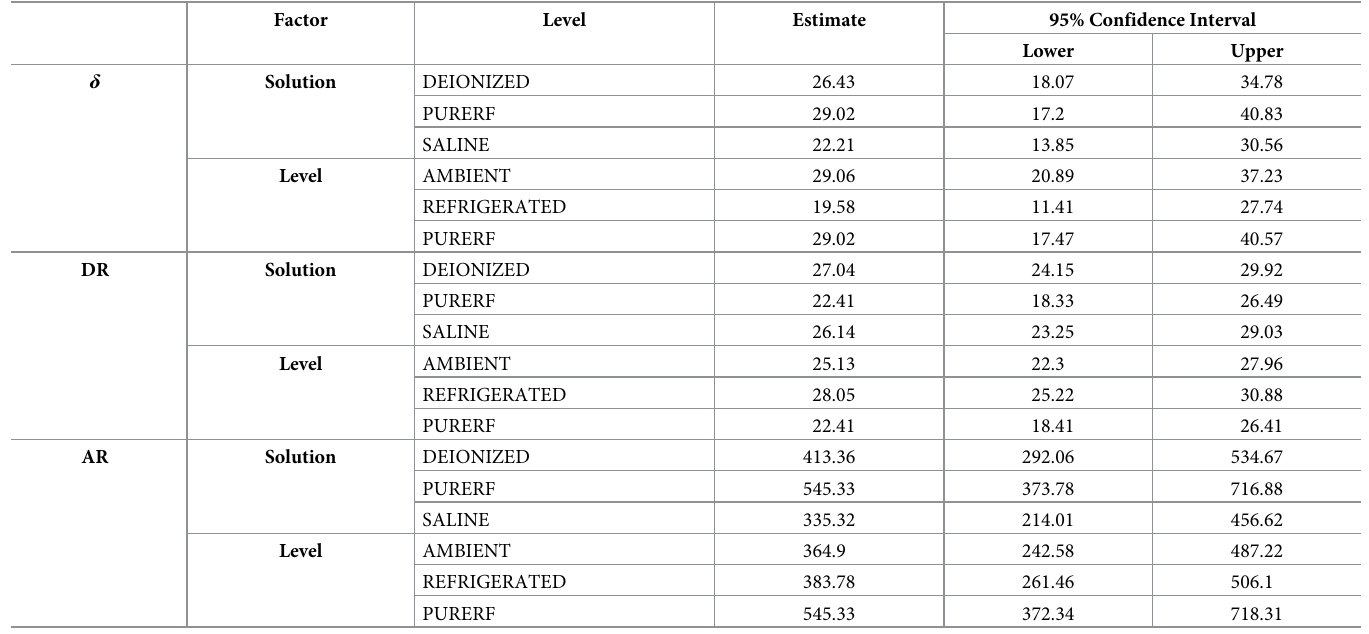
Table 3. Estimated marginal averages of the performance indices for the factors solution type and temperature